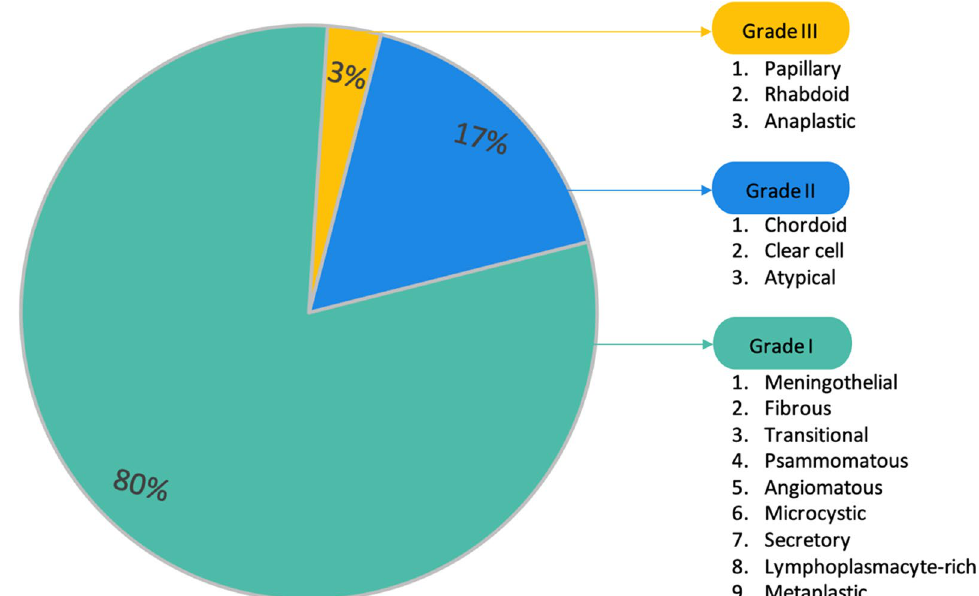
Fig. 2 2016 WHO Subtypes and Grades [35,